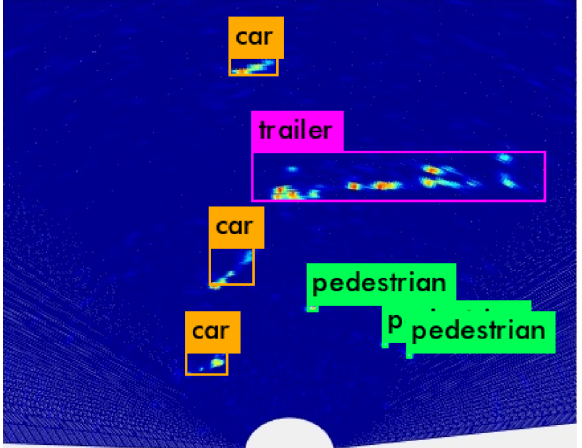
Figure 5. Detection and classification results of our proposed